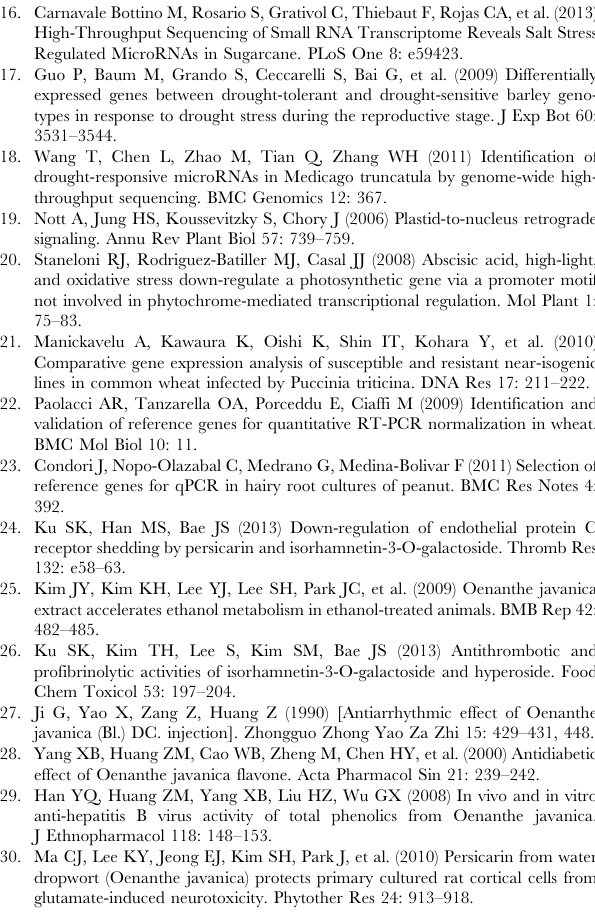
Figure S1 The phenotype of Oenanthe javanica . Table S1 Primer sequences. Table S2 Raw Cq values in Oenanthe javanica. Plants were submitted to the following treatments: Heat, Cold, Salt,